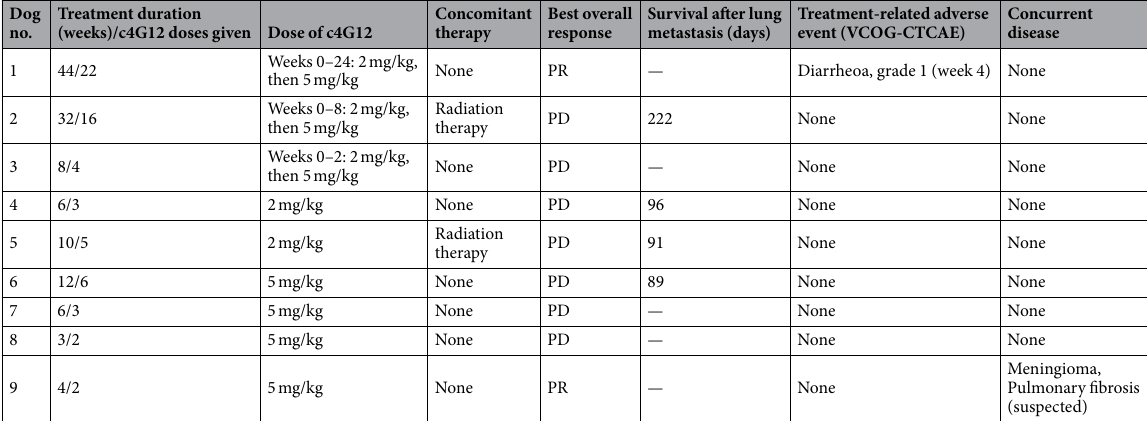
Dog Treatment duration no. (weeks)/c4G12 doses given Dose of c4G12